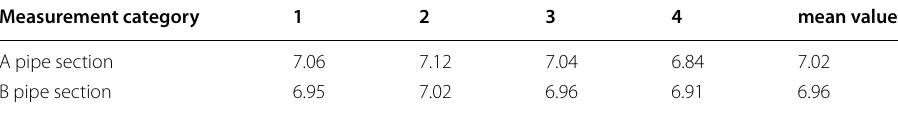
Table 1 The wall thickness measurement results